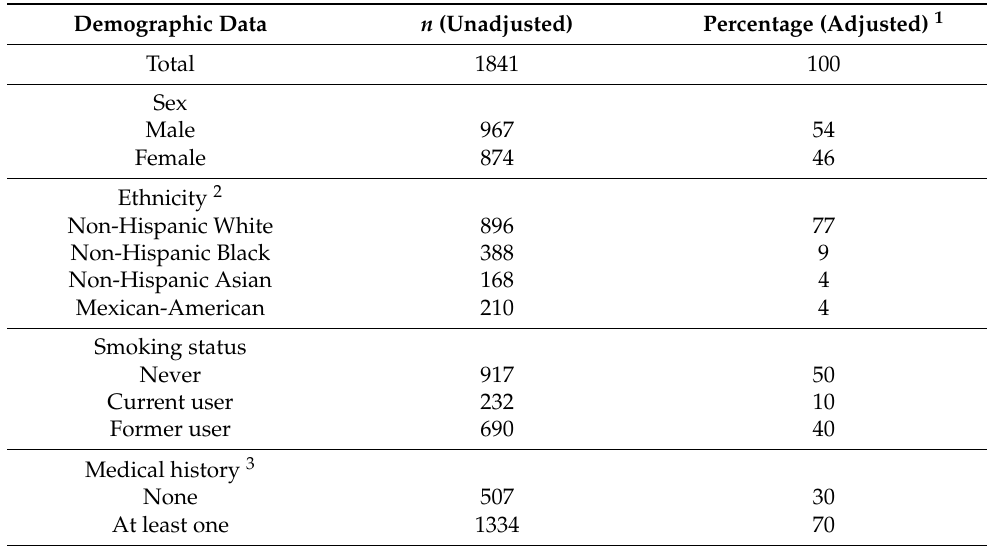
Table 1. Background characteristics of older adults 60 years and above, NHANES 2013–2014. Demographic